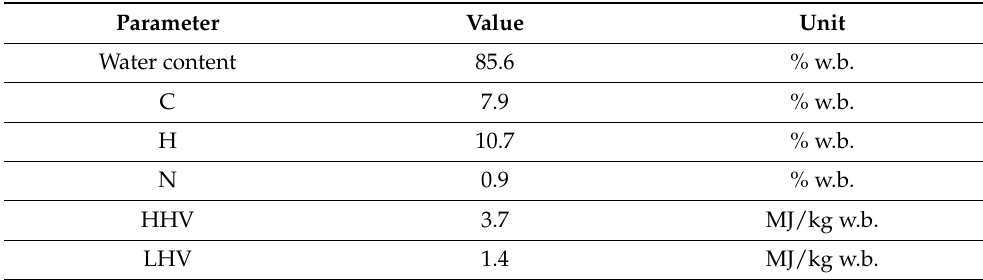
Table 11. Results of liquids (from SPYRO pilot plant) analysis.